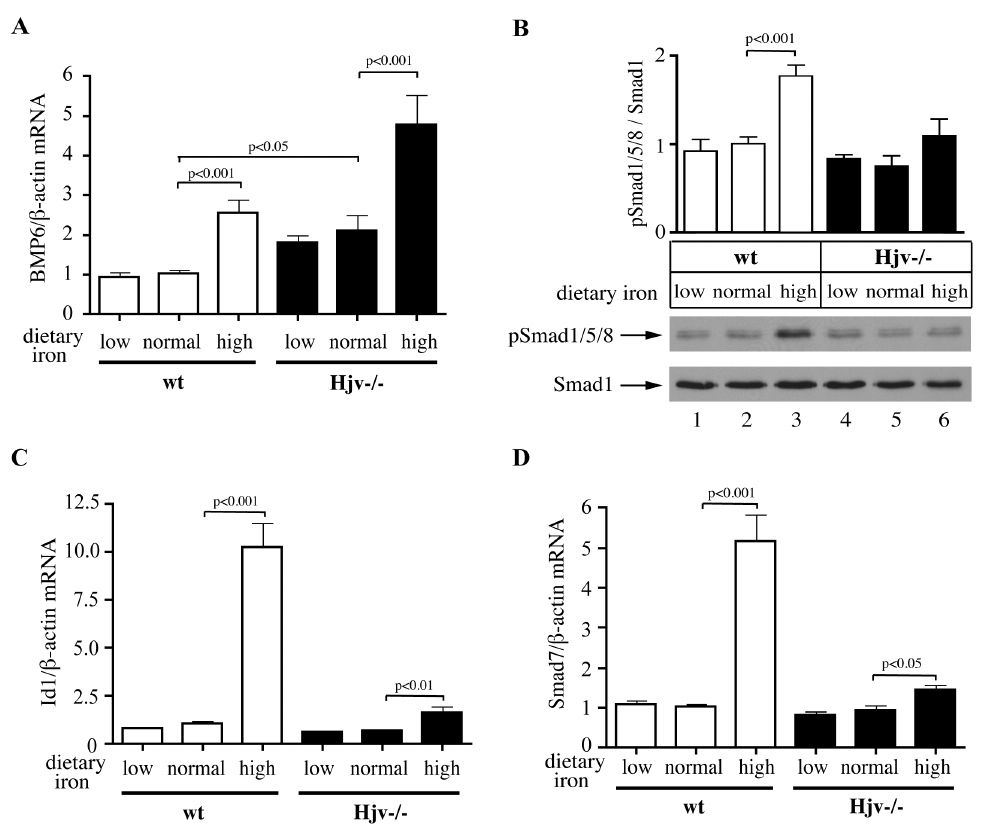
Figure 4. Iron-loaded Hjv 2 / 2 mice mount an appropriate BMP6 mRNA response but exhibit defective Smad signaling. RNA and protein lysates were prepared from livers of Hjv 2 / 2 and wild type mice described in Fig. 1 and used for qPCR and Western blotting, respectively. (A) Expression of Bmp6 mRNA. (B) Analysis of Smad1/5/8 phosphorylation with a phospho-specific pSmad1/5/8 antibody; a representative Western blot with samples from each group (n=1) is shown at the bottom. Blotting with an antibody against total Smad1 serves as loading control. Densitometric quantification of all Smad1/5/8 phosphorylation data (corresponding to n=9 mice for each group), normalized to total Smad1, is shown on top. (C and D) Expression of Id1 and Smad7 mRNA. Data are presented as the mean 6 SEM. The p values were calculated by using one-way ANOVA with Bonferroni post-test correction. Detailed statistical analysis is provided in Table S1.